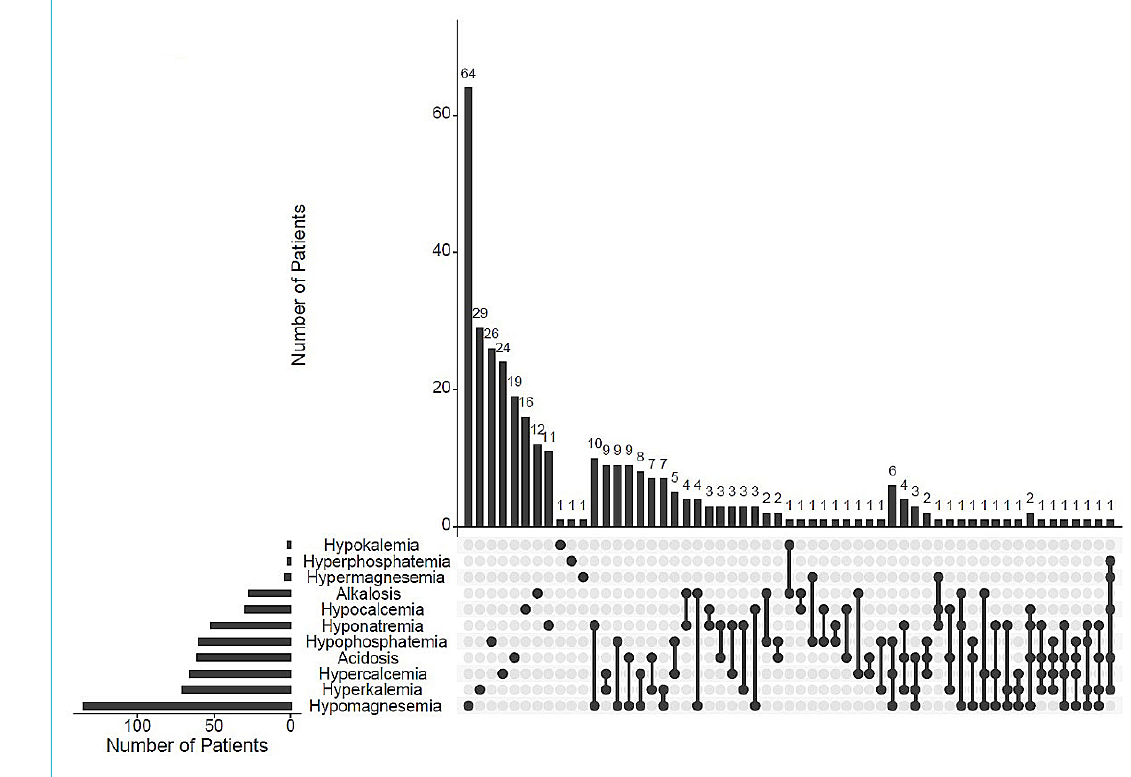
Figure 2: UpSet plot of combinations of acid base and electrolyte disorders. The bar chart on the left displays the total number of patients for each electrolyte disorder. The upper bar chart shows the number of patients with one, two, three or more combinations of acid base and elec- trolyte disorders. On the lower panel single dark dots indicate a single electrolyte disorder; dark connected dots indicate combinations of two or more